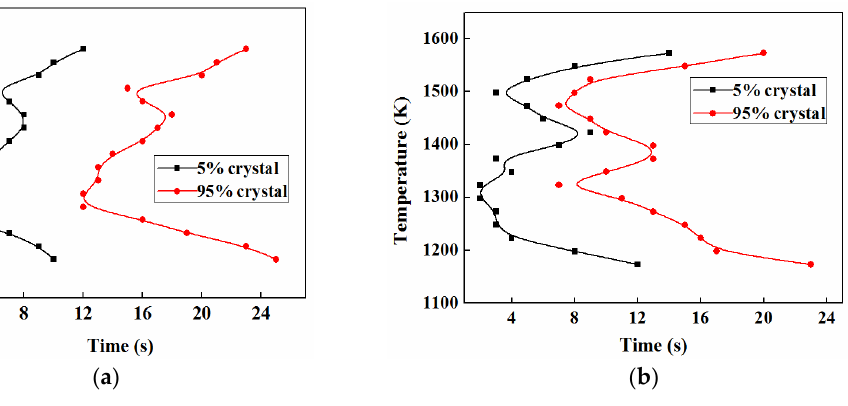
Table 3. Peak analysis of Raman spectra in the mold fluxes.